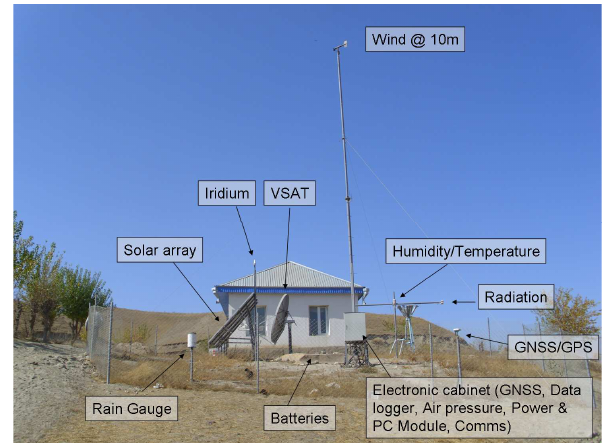
Fig. 2. CAWa station Dupuli (Tajikistan) with a typical sensor setup. The station is solar powered. Subsurface sensors are not shown.